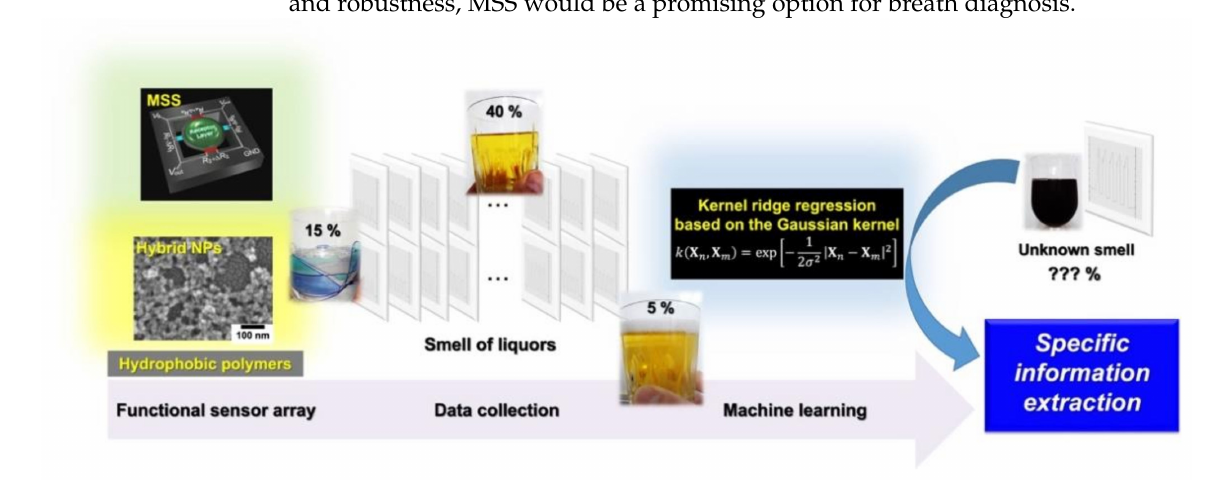
Figure 16. Overview of the quantification of alcohol content from the smell of liquors by combining machine learning and nanomechanical sensing. In the first step, the odor sample is converted to response signals with the MSS. From the signals, characteristic features are extracted. By performing machine learning-based regression, alcohol content is determined. Reprinted from Ref. [8], the author licensed under CC-BY 4.0.